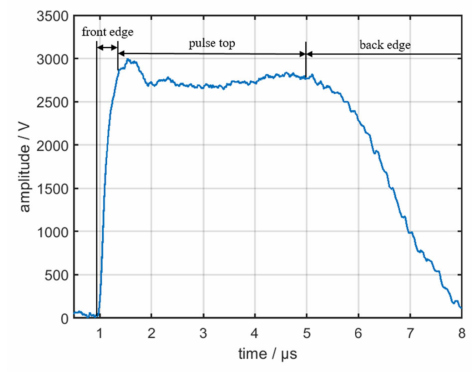
Figure 13. Envelope of the radar signal.